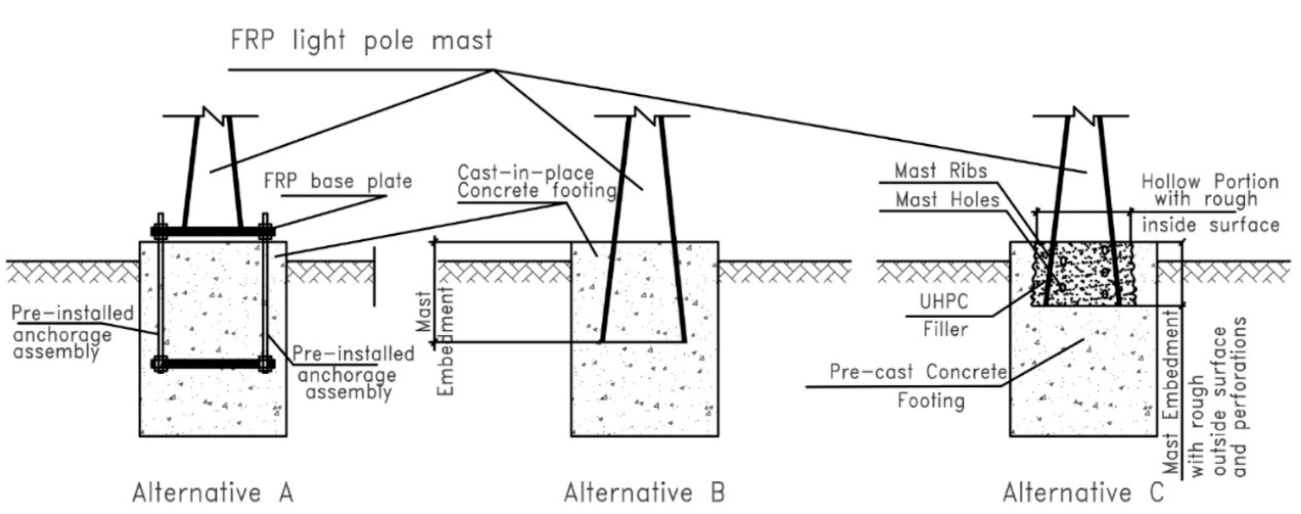
Figure 9. Anchorage options for FRP pole, adapted from Ref. [22].